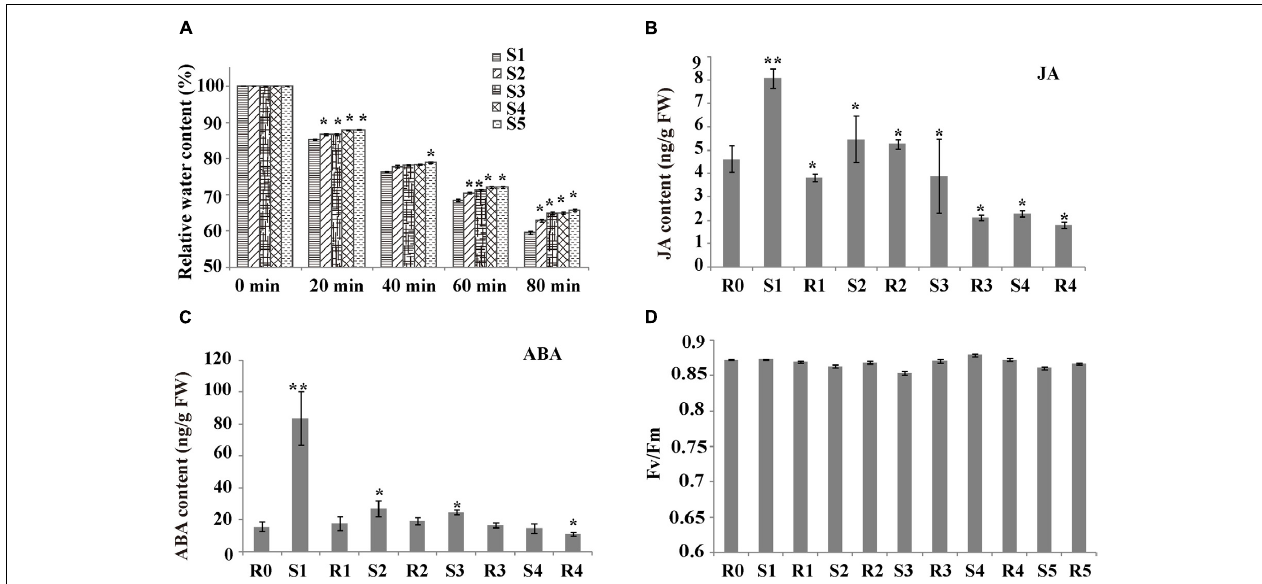
FIGURE 1 | Plant response parameters during drought training treatment. (A) Relative water content (RWC) of the sampled leaves, after air drying for the indicated times. Values are the mean ± SD ( n = 10). Within each water treatment, asterisks indicate significant differences by Tukey LSD test ( ∗ P < 0.05). (B) Hormone levels during drought treatment. Levels of JA were measured at the indicated times. Values are the mean ± SD ( n = 5). Within each water treatment, asterisks indicate significant differences by Tukey LSD test ( ∗ P < 0.05, ∗∗ P < 0.01). (C) Hormone levels during drought treatment. Levels of abscisic acid (ABA) were measured at the indicated times. Values are the mean ± SD ( n = 5). Within each water treatment, asterisks indicate significant differences by Tukey LSD test ( ∗ P < 0.05, ∗∗ P < 0.01). (D) Photosynthesis rate of plants exposed to stress cycles during the initial watered (W) state and on recovery (R1–R5) from one or more stresses. Values are the mean ± SD ( n =